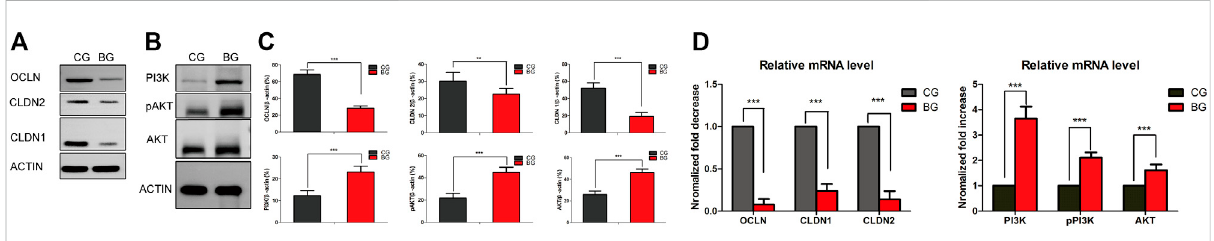
FIGURE 8 (A) Representative Western blots of the proteins OCLN, CLDN1, and CLDN2 in control and blistered human skin. (B) Representative Western blots of the proteins PI3K, AKT, and P-AKT in control and blistered human skin. (C) Expressions of the OCLN, CLDN1, and CLDN2 proteins were signi fi cantly decreased and those of PI3K, AKT, and pAKT were signi fi cantly increased in blistered skin compared with normal skin. OCLN: occludin, CLDN1: claudin 1, CLDN 2: claudin 2. (*: p < 0.05, **: p < 0.01, and ***: p < 0.001). (D) mRNA expression levels of occludin and claudins 1 and 2 were measured by qRT – PCR, and it was found that occludin, claudin 1, and claudin 2 expressions were decreased in blistered skin. In contrast, the mRNA expression levels of PI3K, p-PI3K, and AKT were signi fi cantly increased in blistered skin. The results are expressed as the mean ± SEM. ***: p <